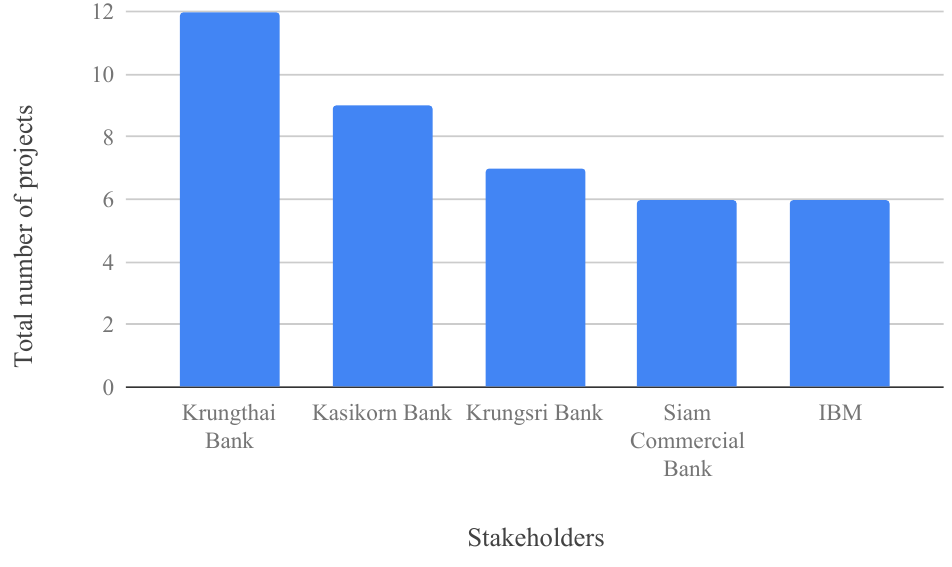
Figure 16. Top five stakeholders of blockchain projects in